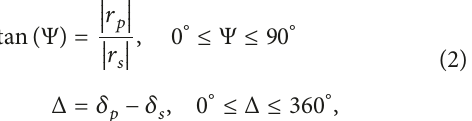
Figure 5: XRD pattern of 200 nm thick ZnO thin film deposited at 18keV and distance of 6 cm at denoted substrate temperatures.